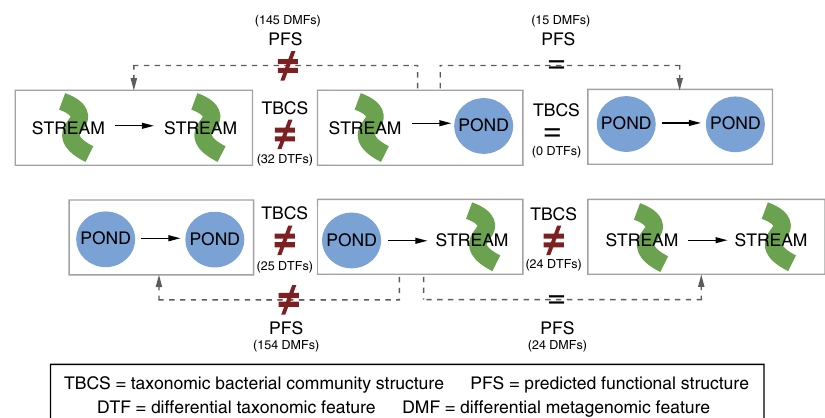
Figure 5 | Schematic summary of gut microbiota results in response to habitat transfer of their hosts. Importantly, despite differing taxonomic community structures between PS and SS groups, their predicted metagenomic features exhibit a lower number of differential features. For the LEfSe-based differential features, the total number of OTUs going into the analysis was 82, and the total number of metagenomic features was 259 metabolism- associated KEGG level 3